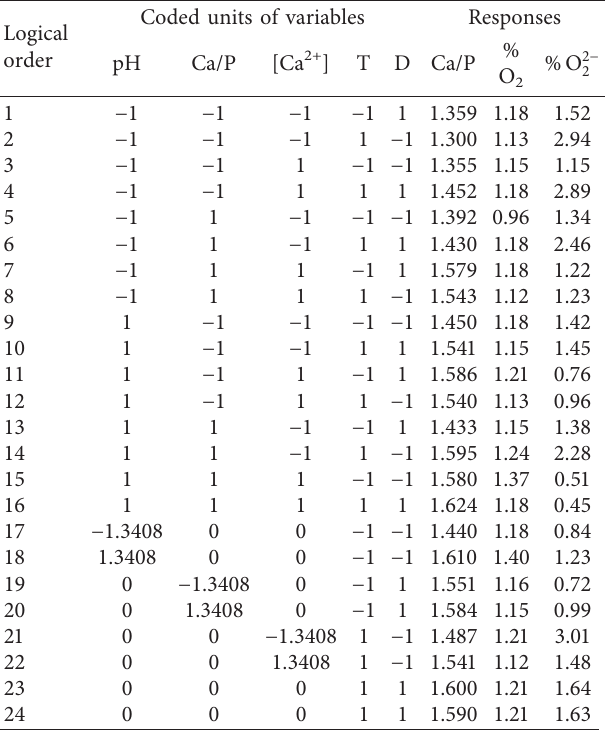
Table 2: Experimental design with